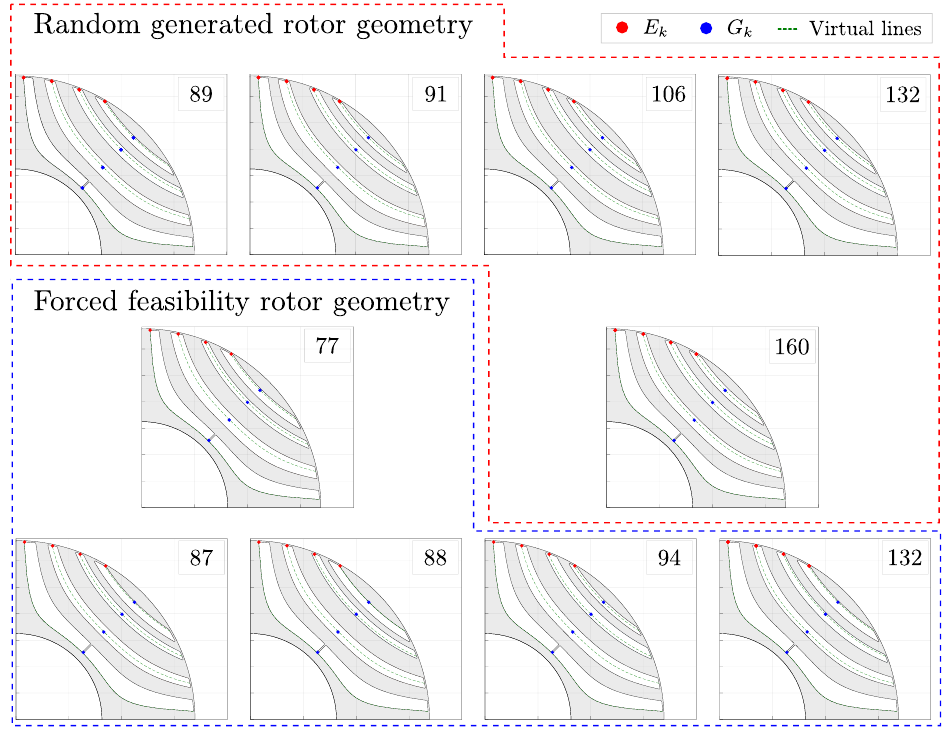
Figure 8. Comparison of optimized geometries in case of random generated and forced feasibility